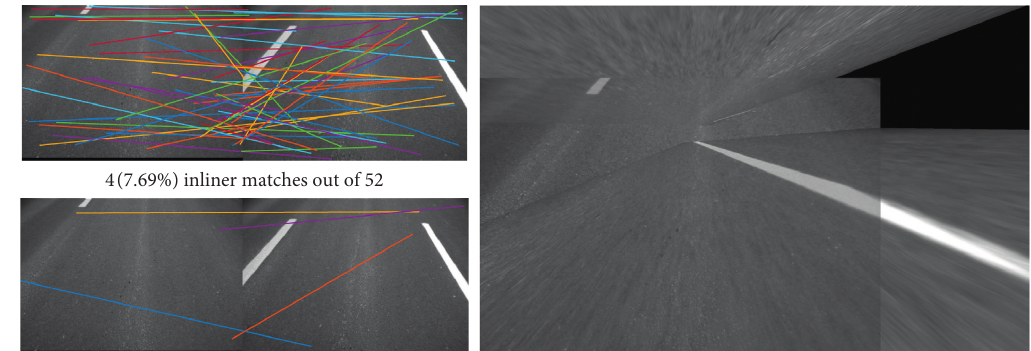
Figure 9: The bad matching and stitching results due to the monotonicity of a pavement.